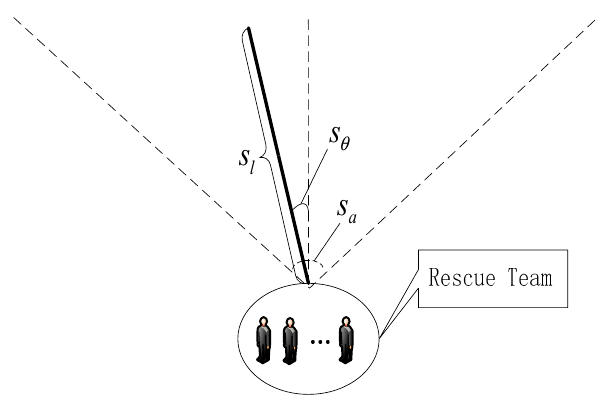
Figure 2. The movement of rescue teams.